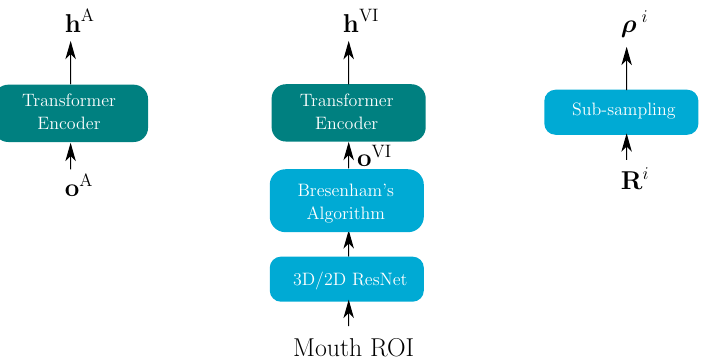
Figure 2. Audio encoder ( left ), video encoder ( middle ) and reliability measure encoder ( right ) for both modalities i ∈ A,VI. The blue blocks are used to align video features with audio features; the turquoise block shows the transformer